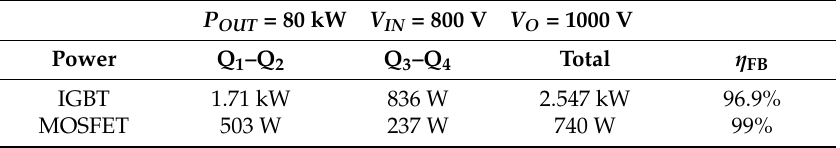
Table 1. Power Dissipation in a Full Bridge at nominal conditions. P OUT = 80 kW, V IN = 800 V, V O = 1000